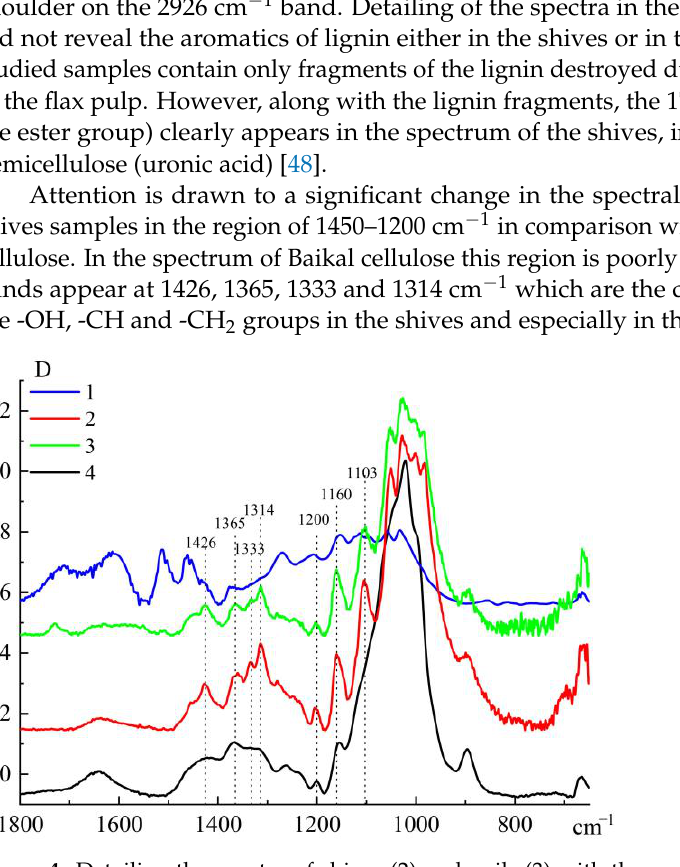
Figure 3. IR spectra of lignin (1), shives (2), noils (3) and Baikal wood cellulose (4).